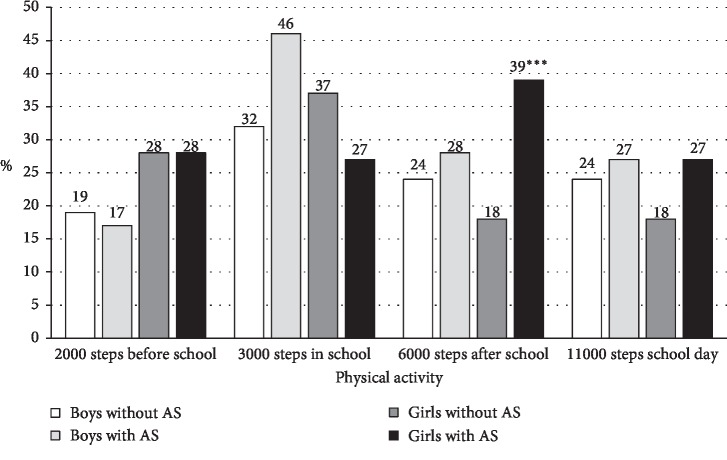
Proportions of boys (n = 187) and girls (n = 339) with and without academic stress (AS) who met the physical activity recommendations in school-day segments.